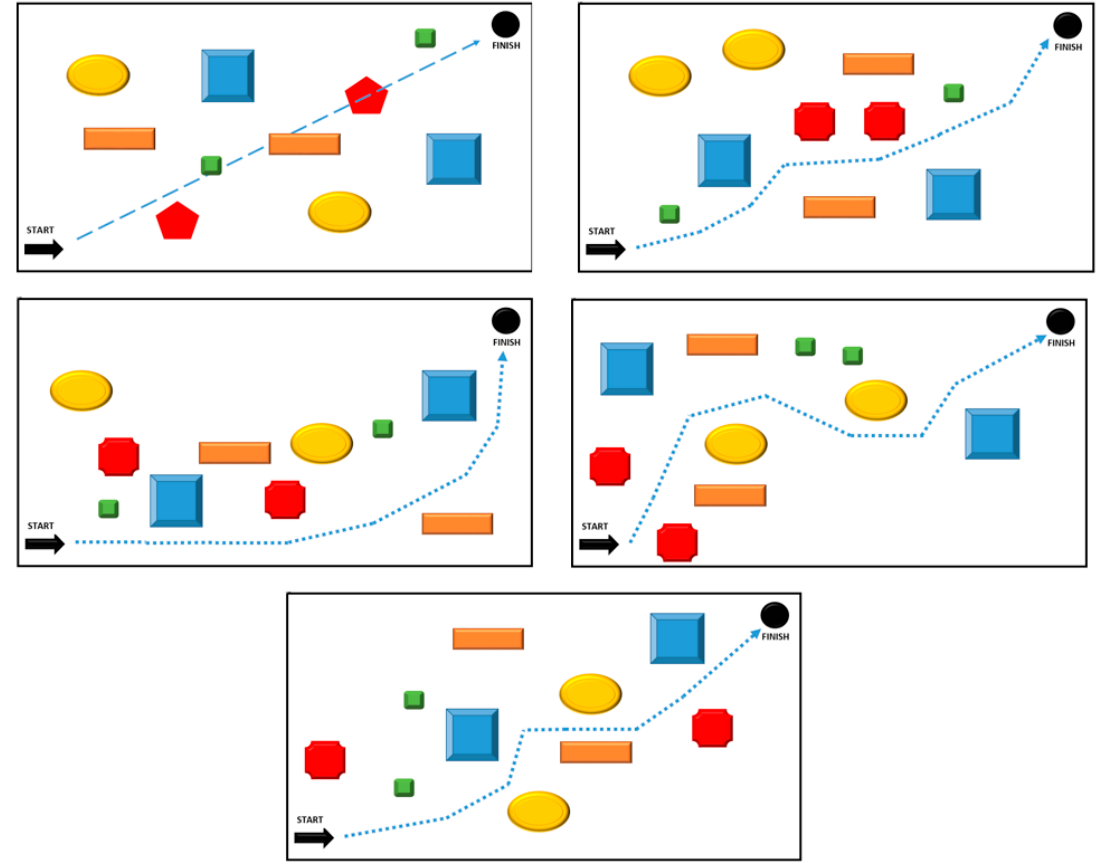
Figure 7. Testing tracks, size of room 20 m × 10 m. Table 2. Transition results of tested persons on 5 different routes in “no learning” mode.